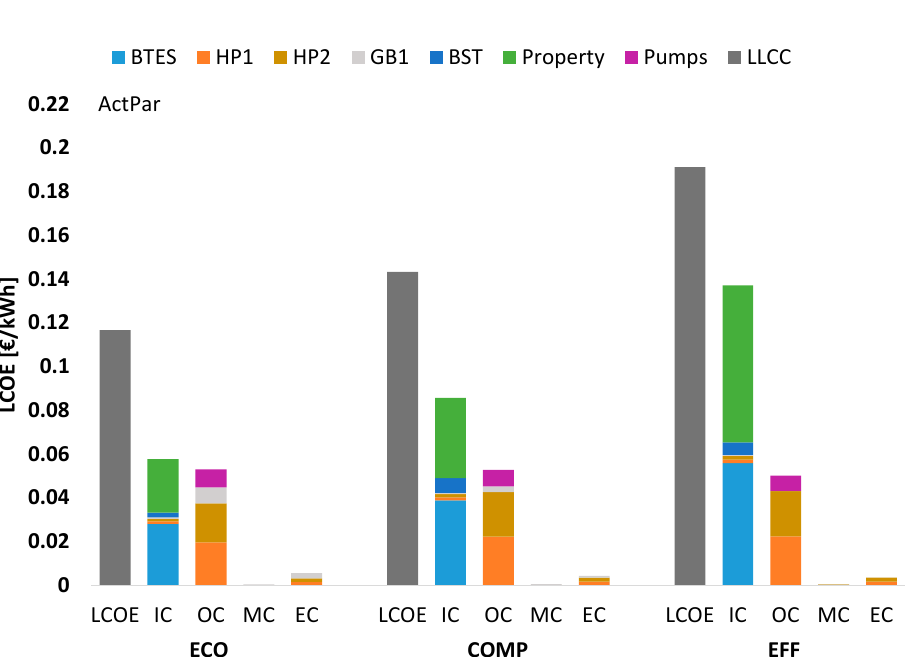
Figure 14. Total and component-wise Levelized Life Cycle Cost ( LCOE ) of ActPar scenario; LCOE is the summation of Initial Cost (IC), Operational Cost (OC), Maintenance Cost (MC) and Emission Cost (EC) for the economical (ECO), the compromise (COMP) and the most efficient (EFF) designs.